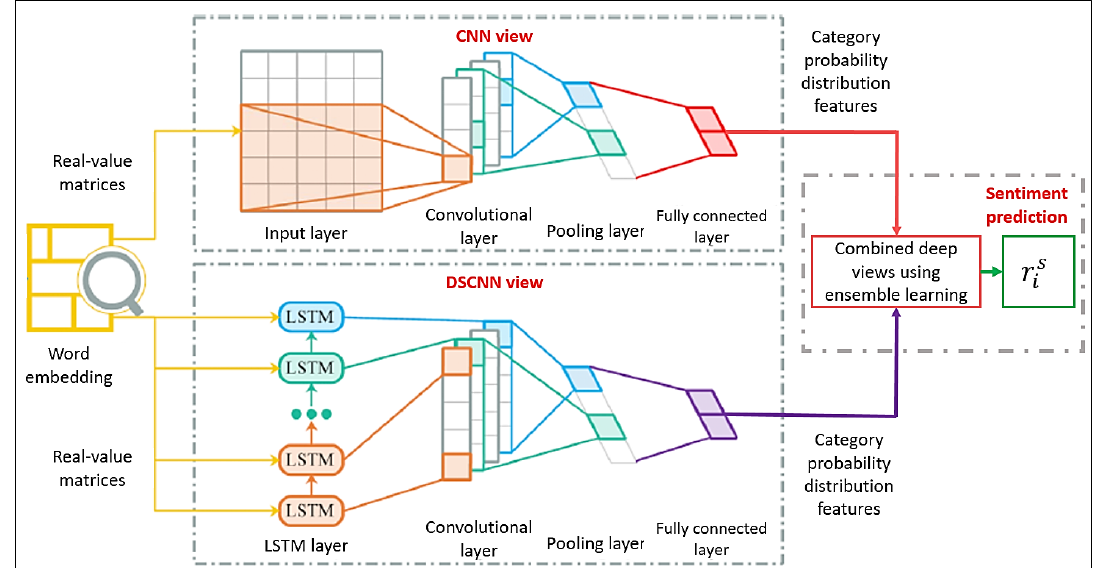
Figure 3. Design of the modified TDVE for text classification [28].